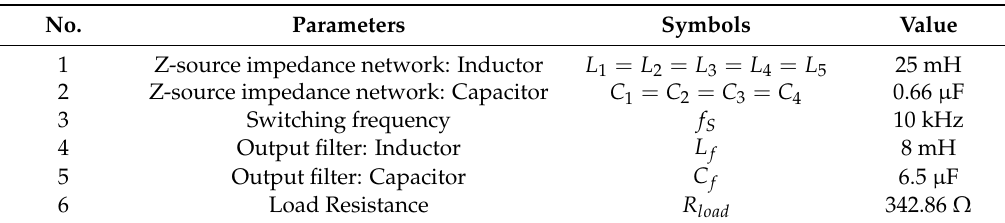
Figure 11. Experimental setup. Table 4. Experimental parameters.